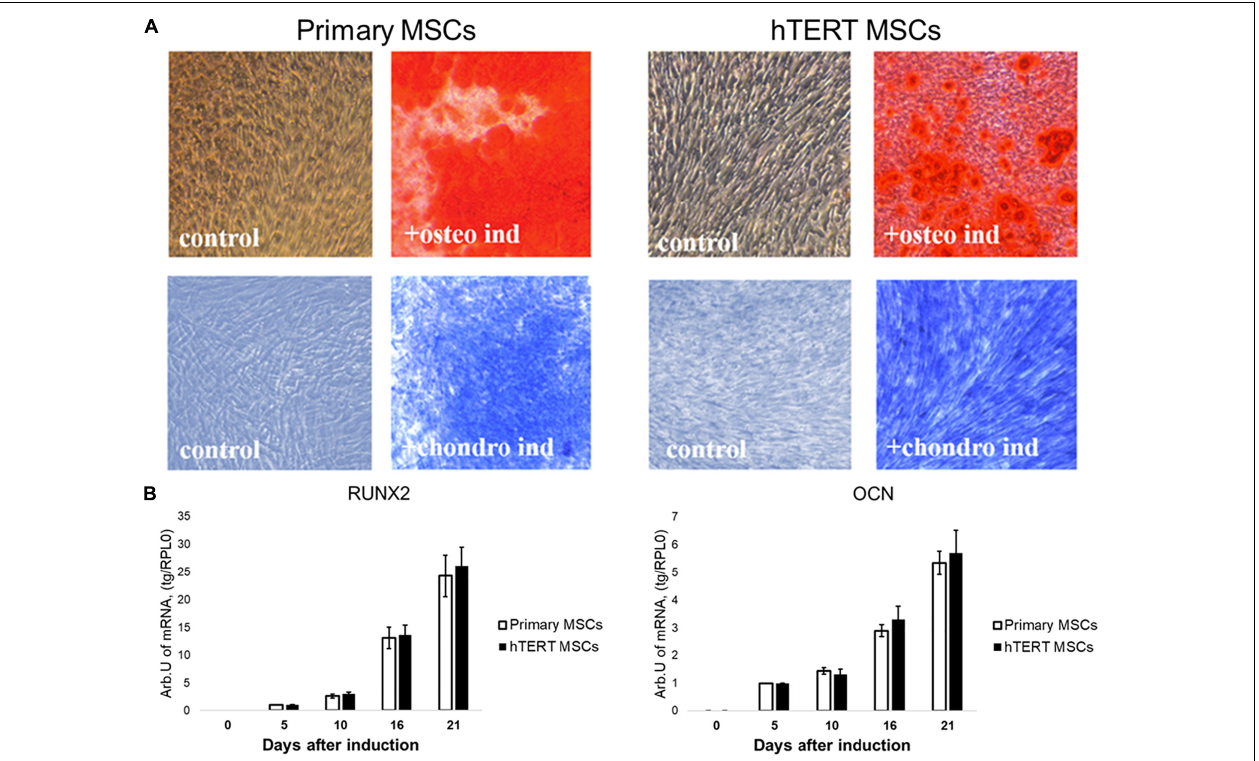
FIGURE 2 | Human adipose-derived primary MSCs and hTERT-MSCs show comparable osteogenic and chondrogenic differentiation potential. Both studied MSCs differentiated into osteocytes (Alizarin Red S staining, “osteo ind”) and chondrocytes (Toluidine Blue staining, “chondro ind”) under inductive conditions. Groups “control” related to the cells cultured in standard conditions without differentiation induction. (A) Representative images, phase contrast microscopy, 10 × objective. (B) Temporal dynamics of marker gene expression during differentiation in MSCs and hTERT-MSC; RT-PCR. Results are presented as mean ± SD, n = 6 independent experiments on primary MSCs from three different donors analyzed with Mann–Whitney U